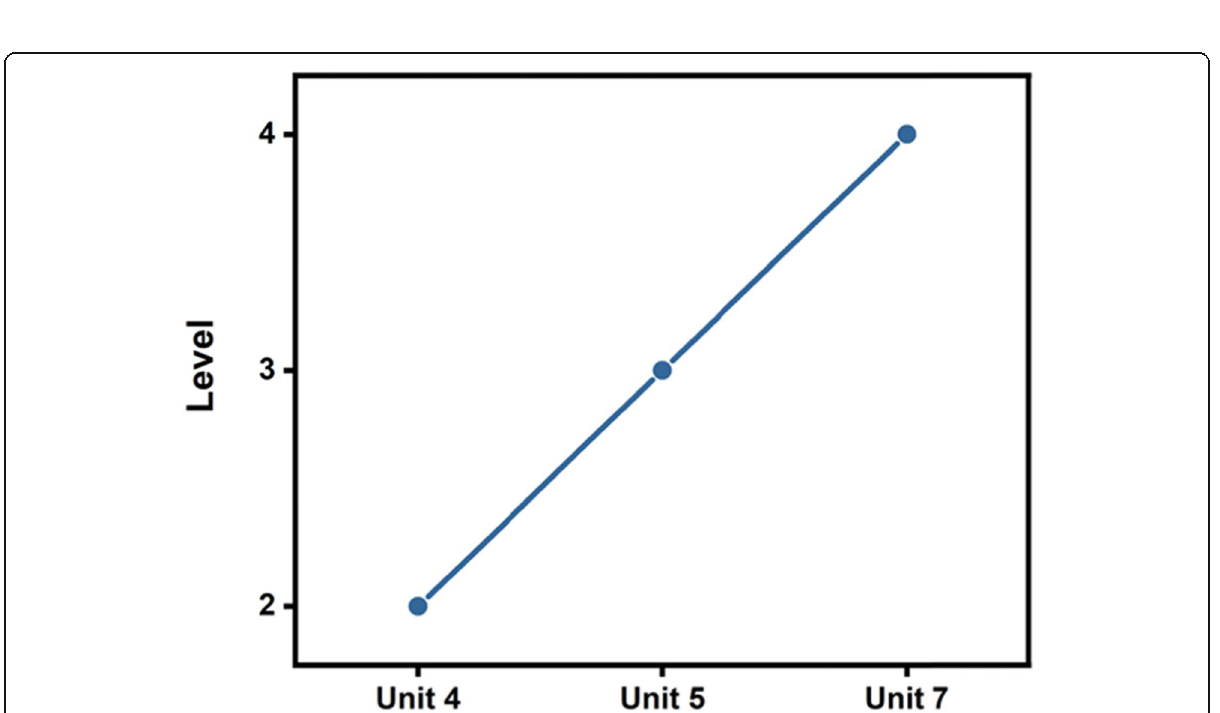
Fig. 5 The change trend of “ motivation to learn chemistry